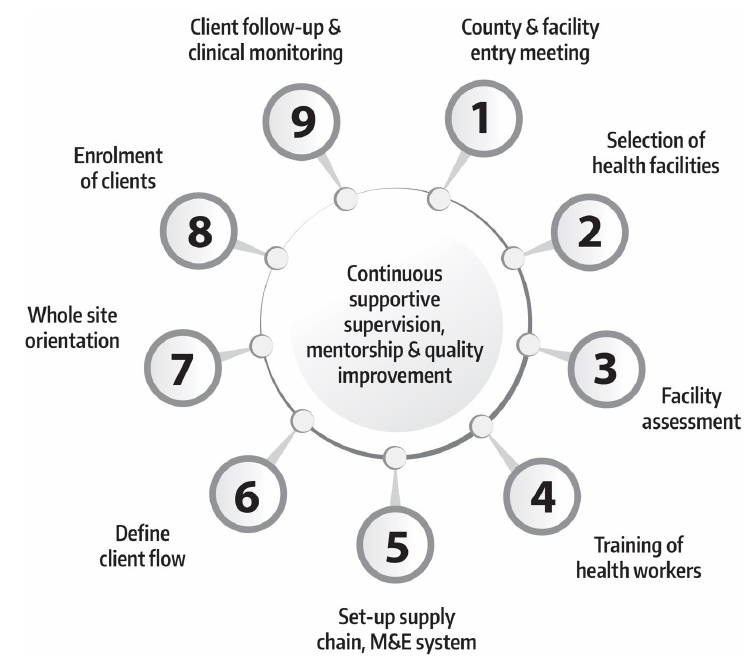
Figure 4. Systematic process of setting up PrEP service delivery sites. (M&E, monitoring and